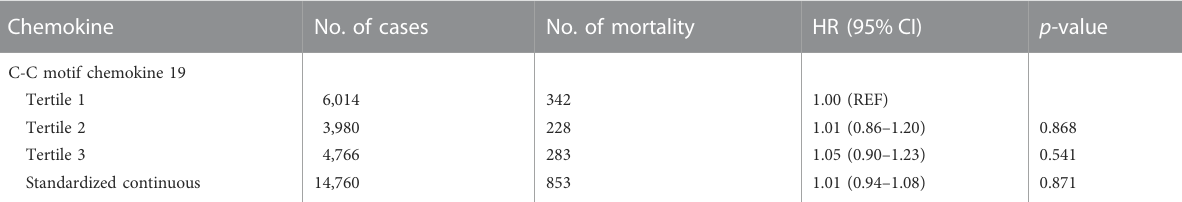
TABLE 2 The association between polygenic risk scores for CCL19 and breast cancer mortality in the UK Biobank.